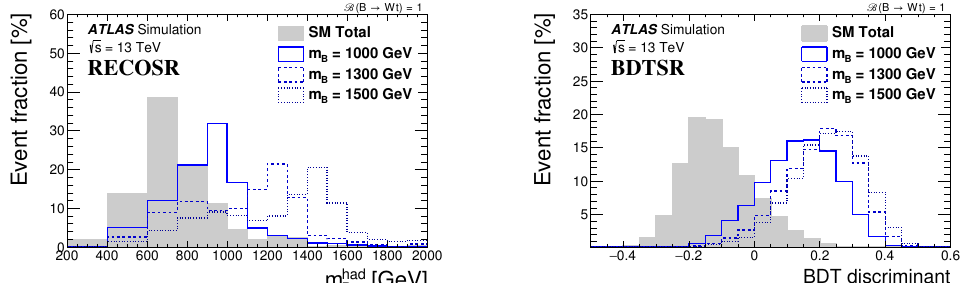
Figure 2 . The reconstructed hadronic B quark mass in RECOSR (left) and the BDT discriminant in BDTSR (right) is shown for the total expected background and selected signal mass points for signal models with ( B Wt ) = 1. In both (cid:12)gures, the distributions are normalised to unity for B ! comparison of the relative shapes at each mass